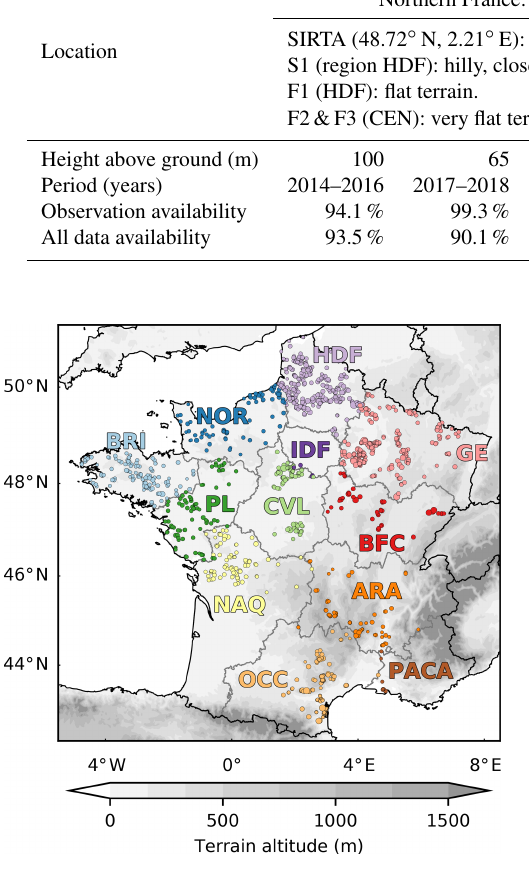
Table 2. Information on the wind-speed measurements used in the study: location (approximate for confidential data) and surrounding environment; LIDAR/anemometers heights; measurement time period (1 to 3 years) and availabilities over this period: availability of the observations alone and availability of combined observed and modelled datasets. SIRTA Northern France: rather flat terrain.